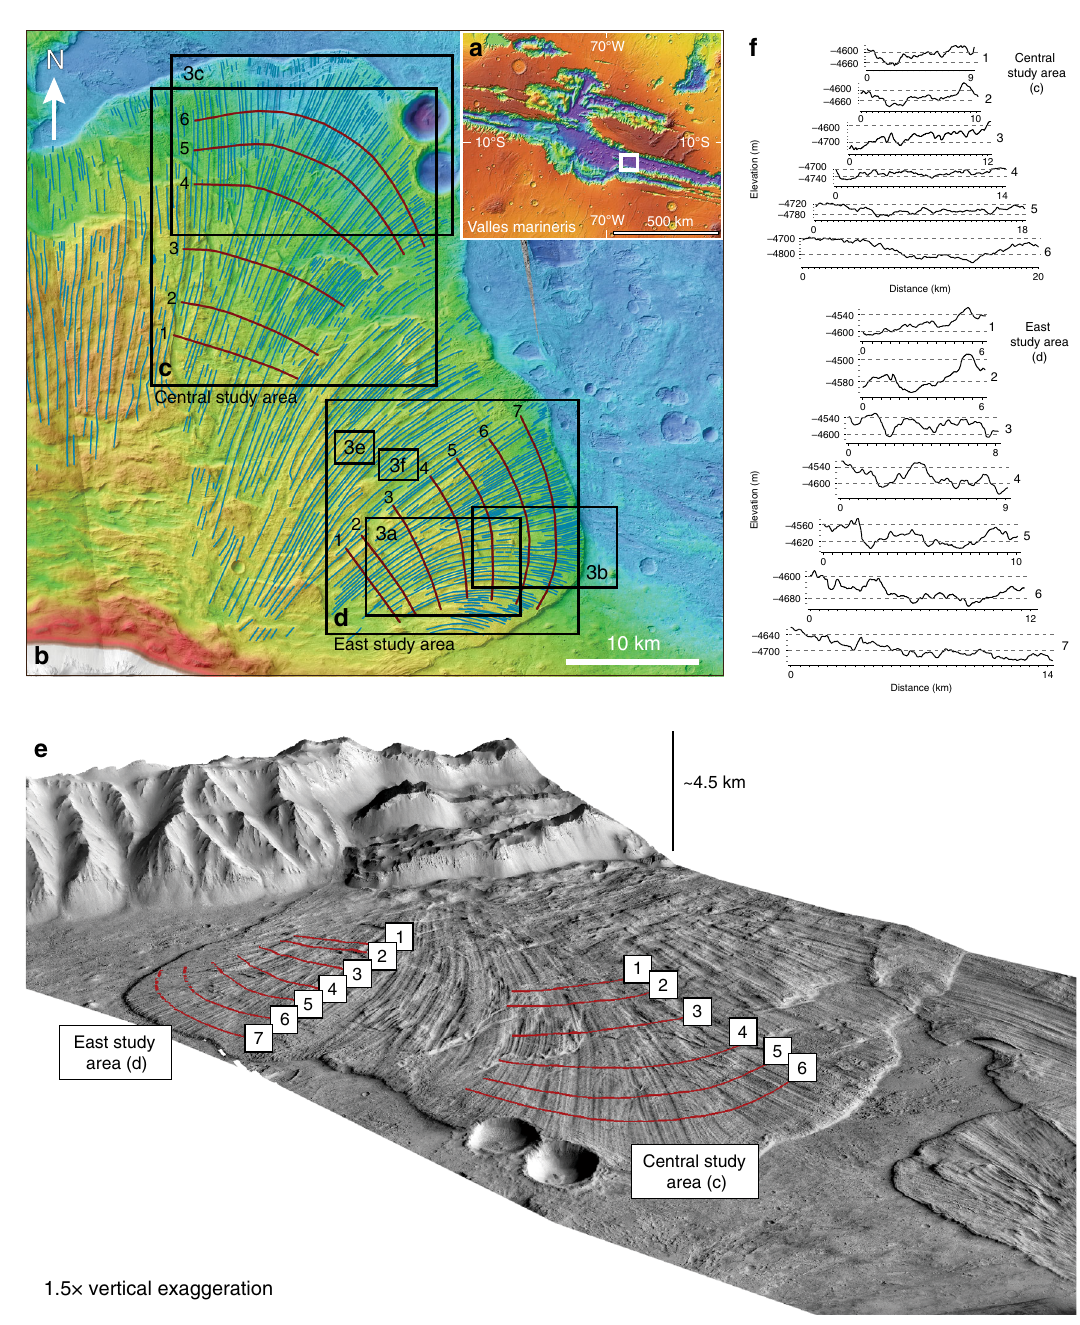
Fig. 1 Area of the study. a Valles Marineris, Mars, showing the location of the landslide that we study here in Coprates Chasma (white box). b CTX Stereo- derived DEMs. c , d Study areas within which morphological and morphometric characterisation is conducted; burgundy lines: topographic pro fi les, numbered from proximal to distal edge of the landslide deposit; blue lines: longitudinal ridges. (3a), (3b), (3c), (3e), (3f): locations of close-up images shown in Fig. 3. e Oblique view of the landslide object of the study. Red lines represent topographic pro fi les, numbered from proximal to distal area (following fl ow direction). f Topographic pro fi les of the landslide deposit of the east and central areas of the